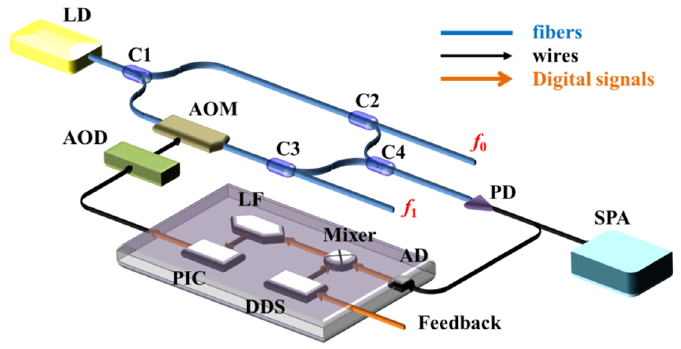
Figure 2. Low-noise multi-frequency lasers generation system.